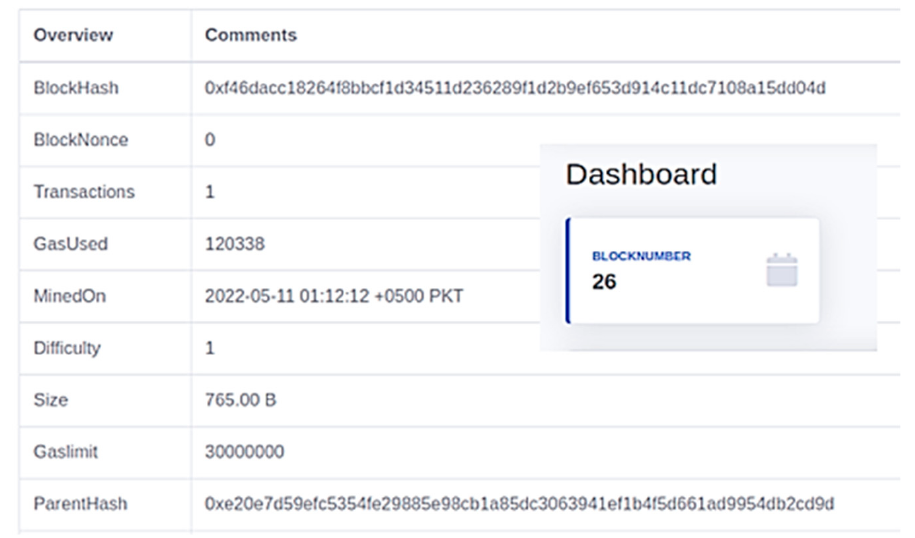
Figure 13. Block details.